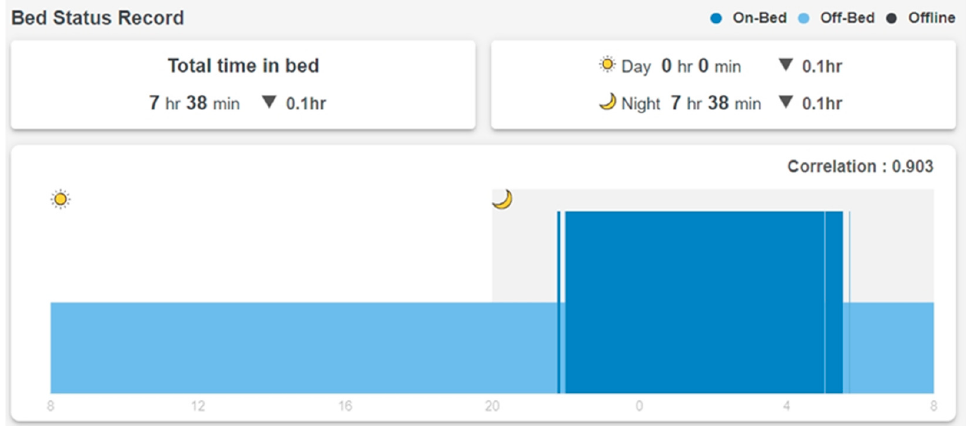
Figure 3. In-bed/off-bed record in 24 h.